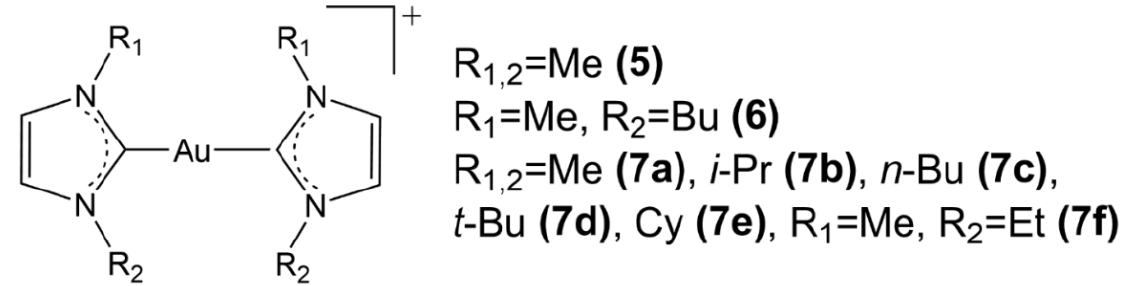
Figure 5. Gold(I) bis-NHC-carbene complexes ( 5 , 6 , 7a – 7f Figure 5 . Gold(I) bis-NHC-carbene complexes ( 5 , 6 , 7a – 7f ).